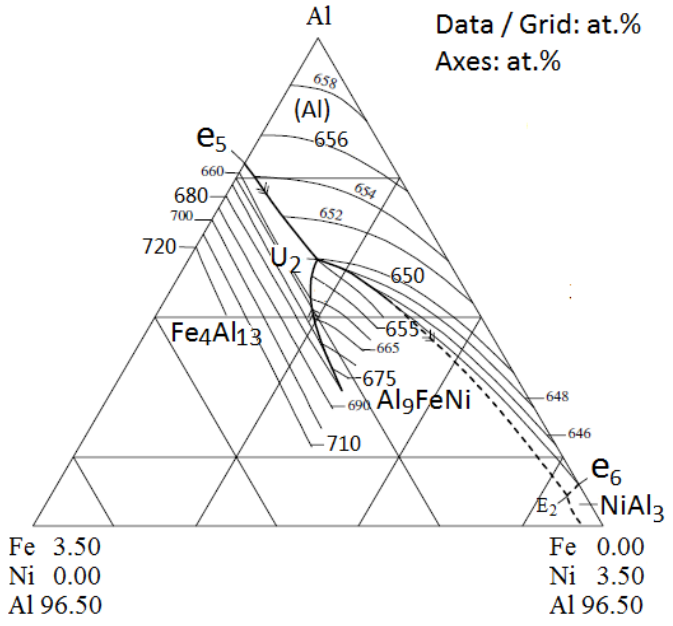
Figure 9. Al–Fe–Ni partial liquidus projection of Al-corner